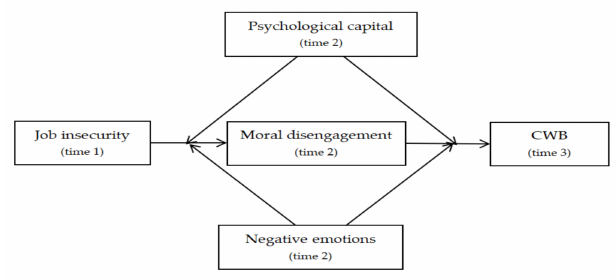
Figure 1. Hypothesized